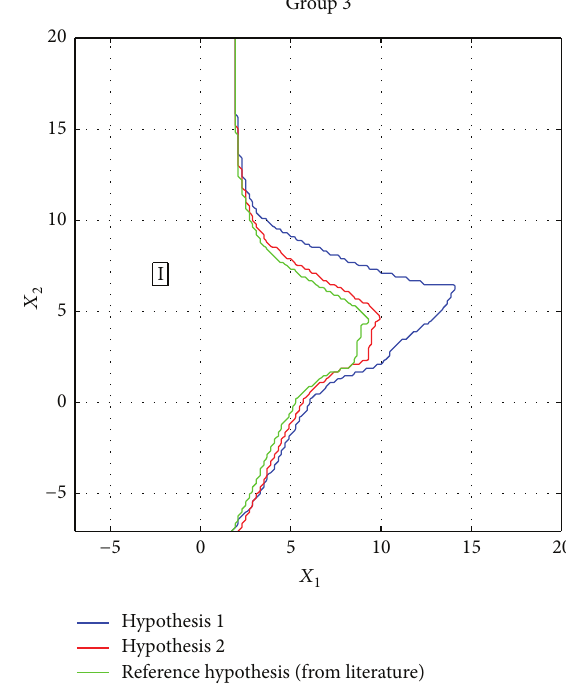
Figure 13: Setup policy (product 2 to product 1).